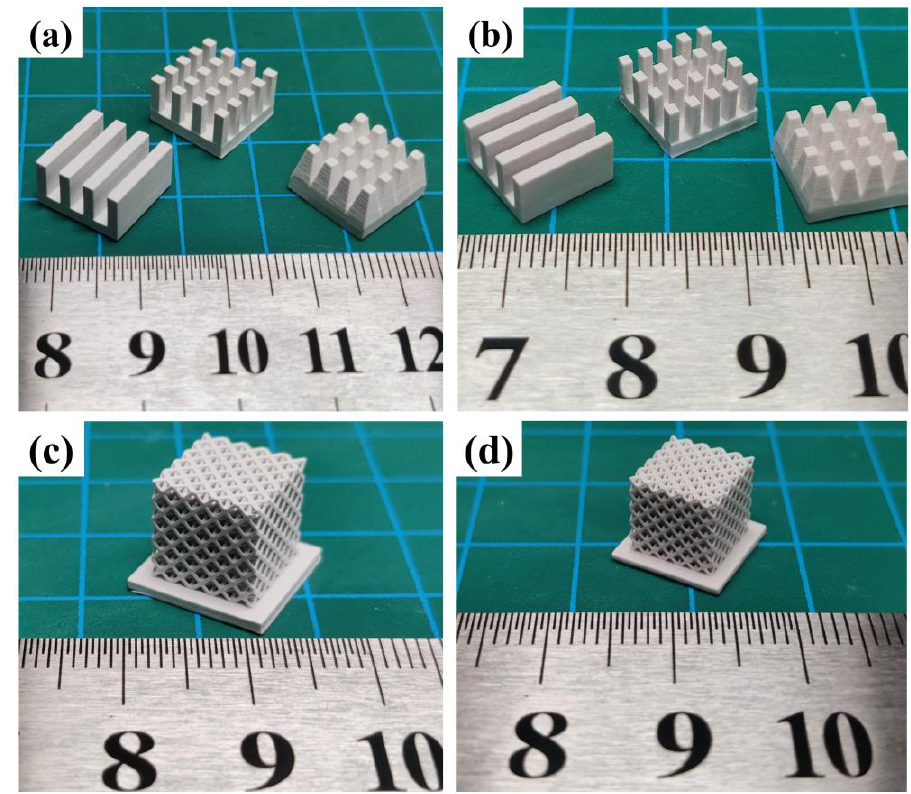
Figure 9. Al 2 O 3 -AlN ceramic components with complex shapes fabricated by DLP: ( a ) Green bodies of heat dissipations before sintering; ( b ) Sintering body of ( a ); ( c ) Green body of lattice structure; ( d ) Sintering body of ( c ).